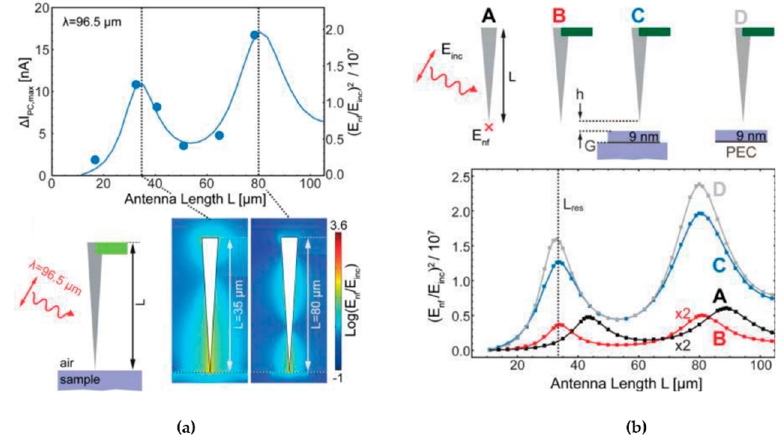
Figure 12. Resonant THz probes: ( a ) Measured THz near-field induced photocurrent as a function of antenna length (blue dots) together with full-wave simulation of the illustrated structure. The resulting simulations of the two resonances marked as the dotted black lines are shown below the plot. ( b ) Illustration and resulting field enhancements 10 nm below the apex as a function of length for four configurations: (A) free-standing tip; (B) tip with a cantilever; (C) tip with cantilever and graphene-based device as described in the text; and (D) tip with cantilever and sample device where graphene has been replaced by PEC. Reprinted with permission from